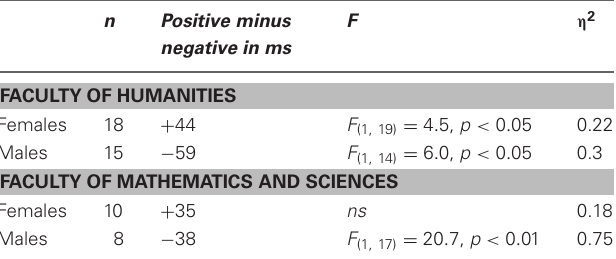
Table 2 | Gender and faculty differences in negative vs. positive